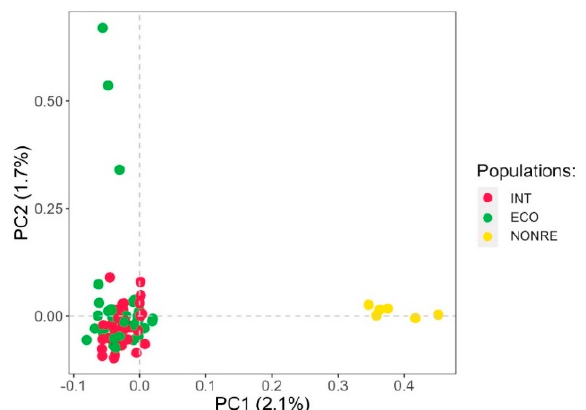
Figure 3. Principal component analysis (PCA) based on 4879 SNPs. Color and sign code: red, populations from integrated orchards (INT); green, populations from organic orchards (ECO); yellow, laboratory population (NONRE).